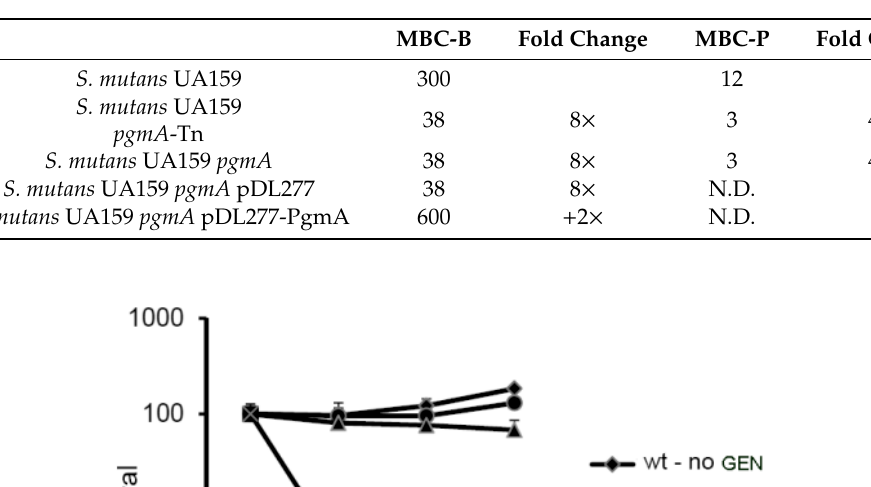
Table 2. Gentamicin Minimum Bactericidal Concentration for Biofilm Cells (MBC-B) and Minimum Bactericidal Concentration for Planktonic Cells (MBC-P) for transposon, knock-out mutants, and complemented strains ( µ g / mL). The data are from a representative experiment performed with three replicates. (N.D. means not determined).